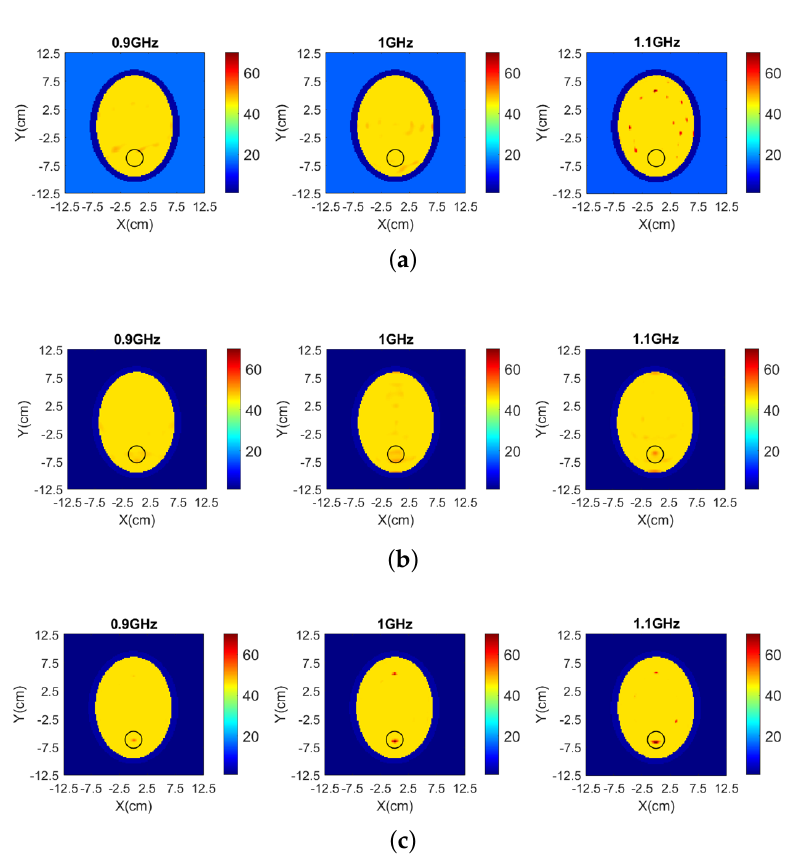
Figure 14. Real part of permittivity reconstructed from simulation data at frequencies 0.9 GHz, 1 GHz and 1.1 GHz for ( a ) the 8-spear patch antenna array operating in infinite matching medium (“System 1”) ( b ) the 8-PSMA array (“System 2”) and ( c ) the 8-MTS-enhanced PSMA array (“System 3”) operating in